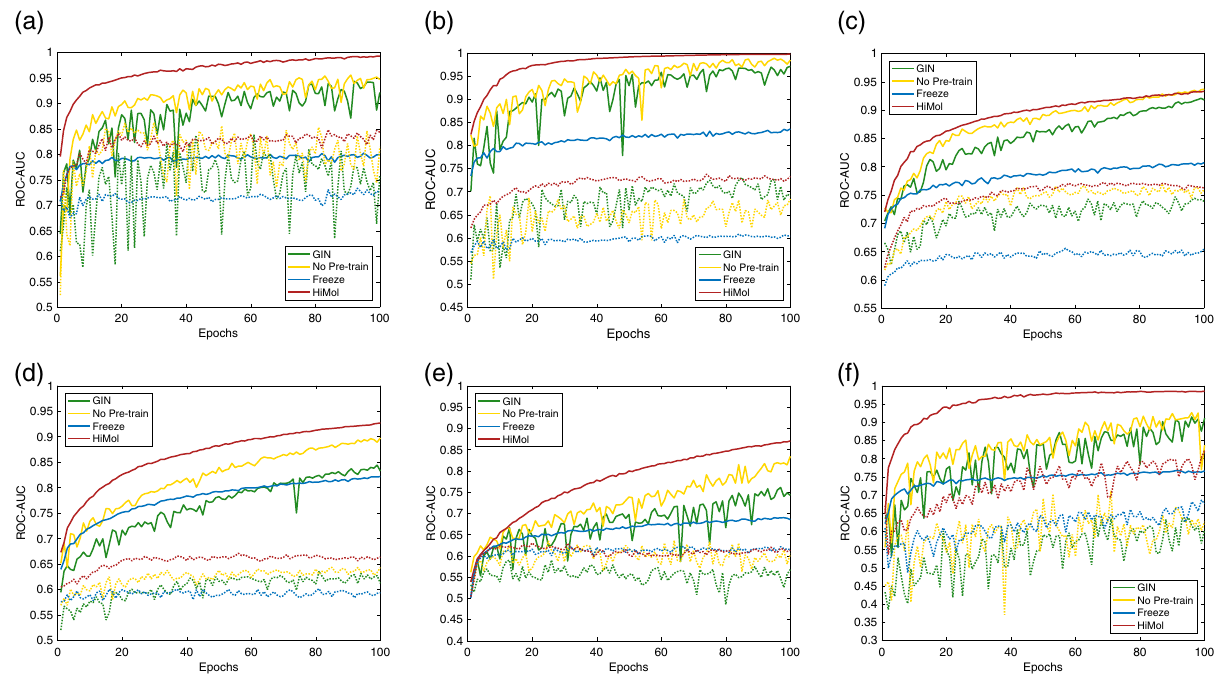
Fig. 4 Training and testing classi fi cation ROC-AUC curves of different fi ne-tuning modes. Solid lines are training curves; dashed lines are testing curves.